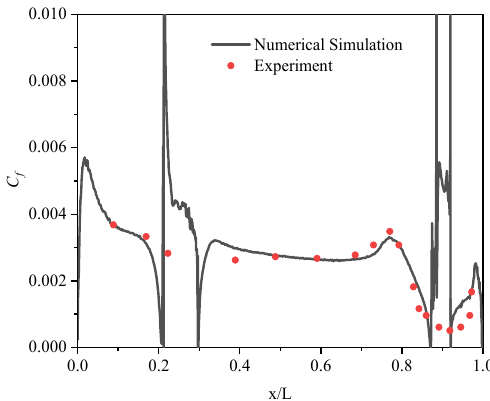
Figure 5. C f along the upper meridian line.